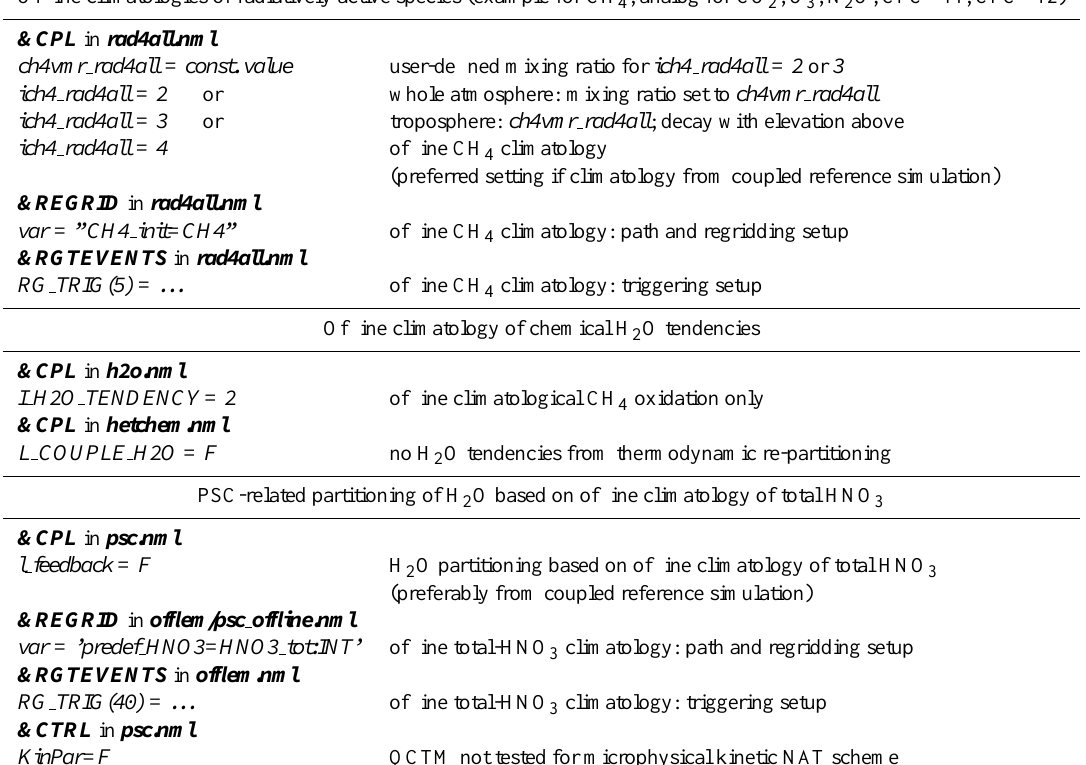
Table A1. Namelist settings required to activate the QCTM for EMAC version 1.11 and higher. Regridding is referred to as rediscretization of an offline field to the ECHAM5 Gaussian grid (see J¨ockel, 2006), triggering as the timed import of the re-gridded field into a running simulation (see Kerkweg et al., 2006). Offline climatologies of radiatively active species (example for CH 4 , analog for CO 2 , O 3 , N 2 O, CFC − 11, CFC −